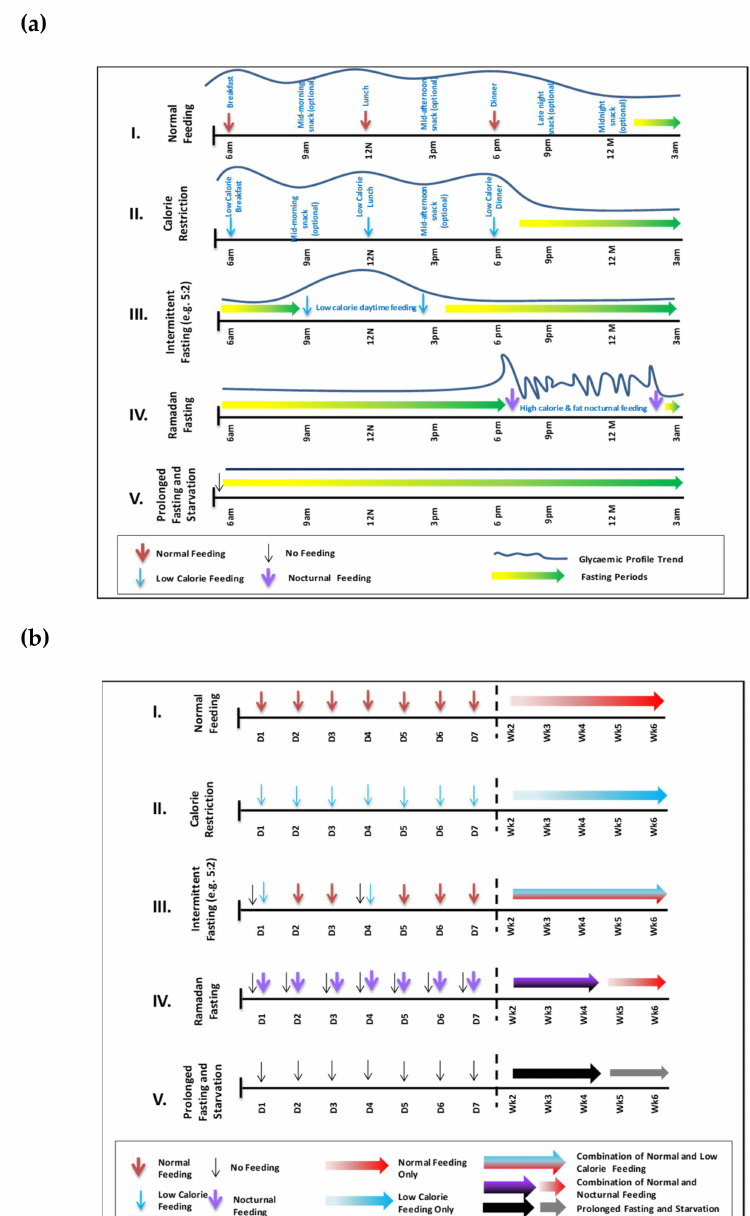
Figure 2. Changes in Feeding Patterns and Energy Intake during Various Fasting Periods. The five feeding and fasting patterns are: (I) normal feeding, (II), calorie restriction, (III) intermittent fasting (e.g., 5:2), (IV) Ramadan fast and (V) prolonged fasting and starvation. ( a ) Hourly Di ff erences in Feeding Patterns between Various Fasting Models: hourly timings of feeding and energy intake (meals) are indicated per day in relation to fasting periods (arrows) and reflected in glycaemic control (traces). ( b ), Daily and Weekly Di ff erences in Feeding Patterns Between Various Fasting Models: daily and weekly feeding patterns are mapped against calorie intake which can be regular such as in in normal feeding (I), indicated by single colour arrows or a combination of low, normal or high calorie intake as in intermittent fasting (III), indicated by mixed colour arrows. Ramadan fast (IV) is unique as it combined low and high calorie intake as indicated by the two single colour arrows. The first week is broken down into seven individual days. Weekly indications follow